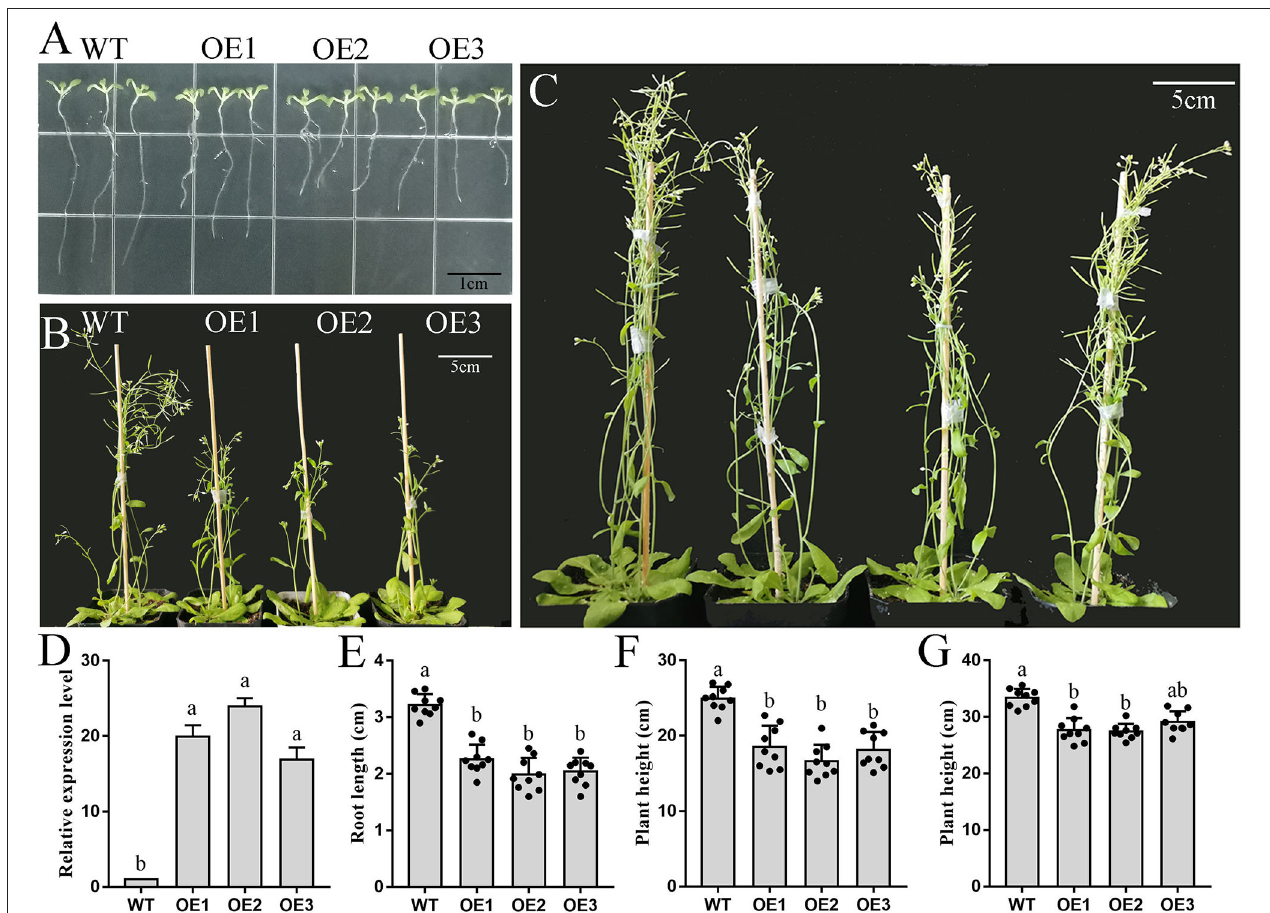
FIGURE 7 | Phenotype and biomass determination of wild-type and PbFAD3a transgenic Arabidopsis. (A–C) Wild-type and transgenic Arabidopsis plants grew for 10 d (A) , 35 d (B) , and 55 d (C) in a long-day photoperiod. (D) qRT–PCR analysis showed the overexpression of PbFAD3a in the seedlings of representative transgenic lines. Biomass data of wild-type and PbFAD3a transgenic Arabidopsis plants grew for 10 d (E) , 35 d (F) , and 55 d (G) in a long-day photoperiod. Data are shown as mean ± SD of nine Wild-type or T3 transgenic plants ( n = 9). Lowercase letters indicate significant differences in the two-tailed Student’s t -test ( p < 0.01). WT, wild-type. OE, overexpression